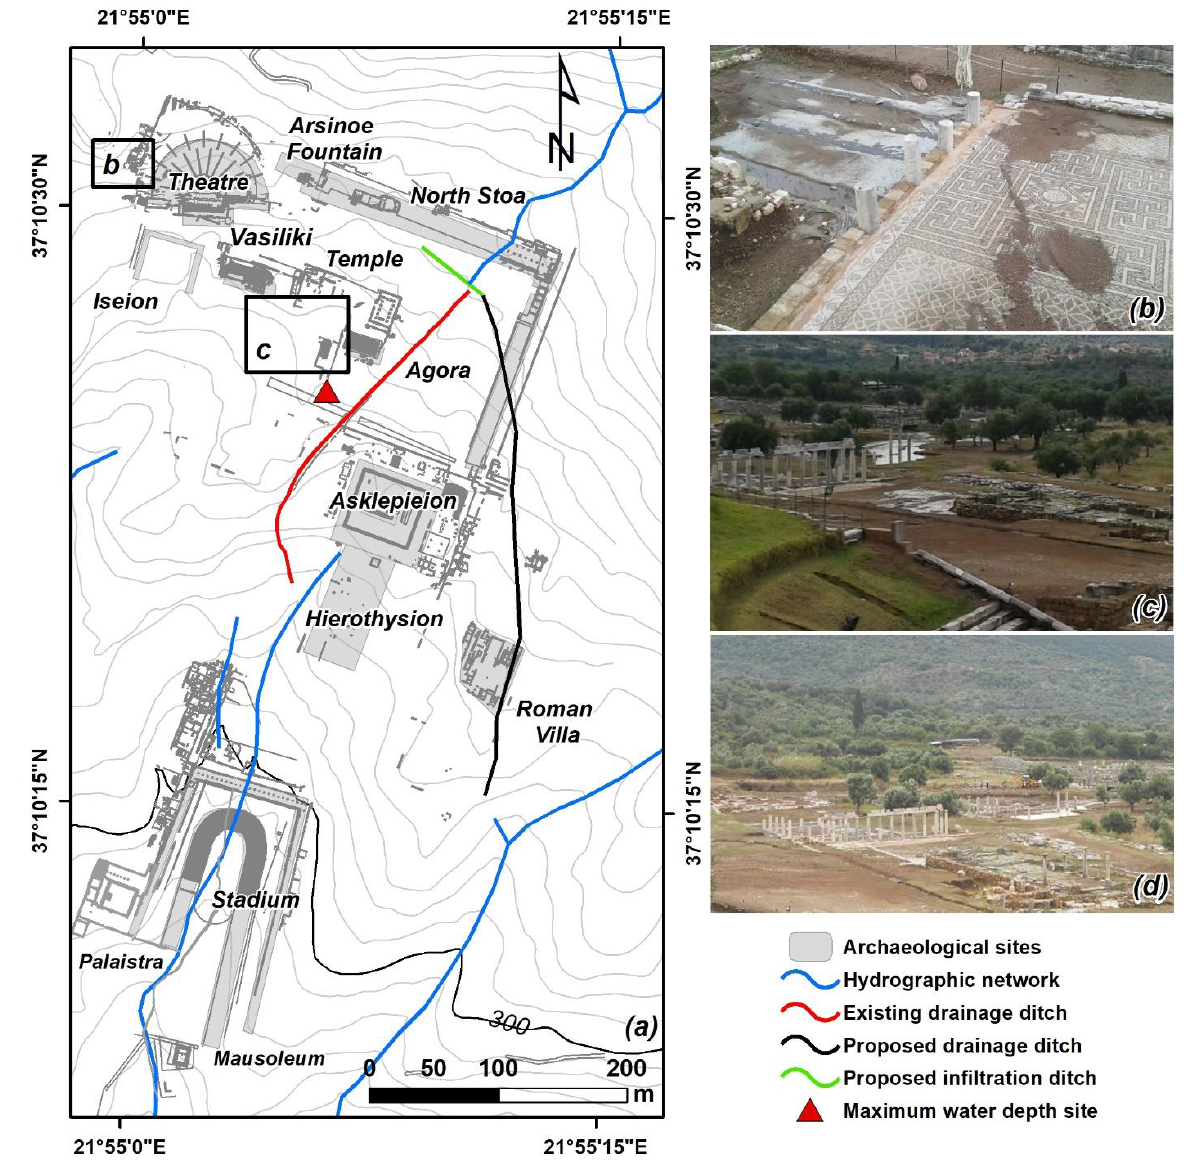
Figure 2. ( a ) Detailed plan of the Ancient Messene archeological site; ( b ) debris deposition related